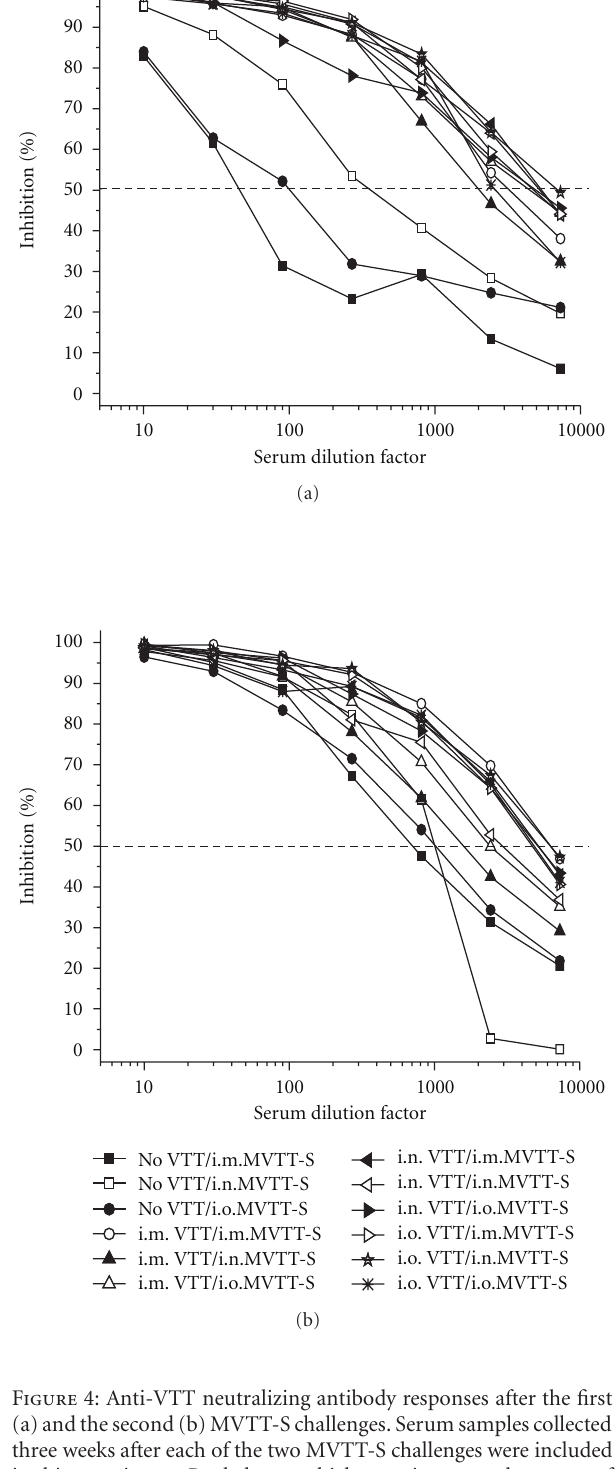
Figure 4: Anti-VTT neutralizing antibody responses after the first (a)and the second (b) MVTT-S challenges. Serum samplescollected three weeks after each of the two MVTT-S challenges were included in this experiment. Pooled sera, which contain an equal amount of serum of each vaccinated mouse in each group, were subjected to each experiment. The X -axis represents the serum dilution factor whereas the Y -axis indicates the percentage of viral inhibition. The dashed horizontal line indicates IC 50 values. The experiment was repeated twice with similar results obtained. As controls, no VTT represents mice, who did not receive